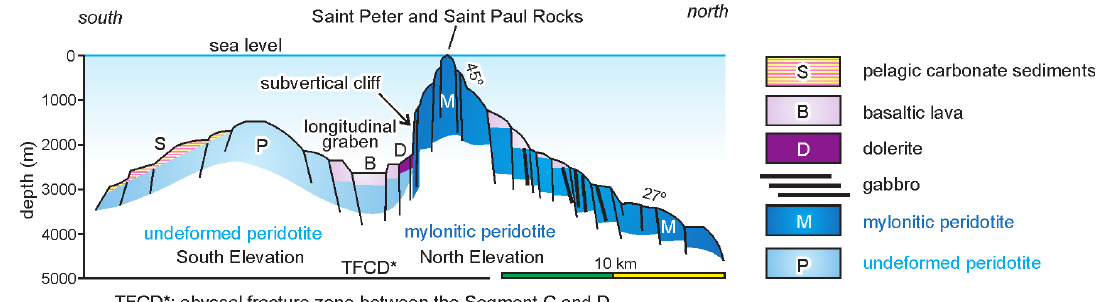
Figure 2 - Composite cross-section of submarine morphology for the Saint Peter and Saint Paul peridotite ridge, compiled from six deep dives performed by the scientific submersible Nautile (Hekinian et al.